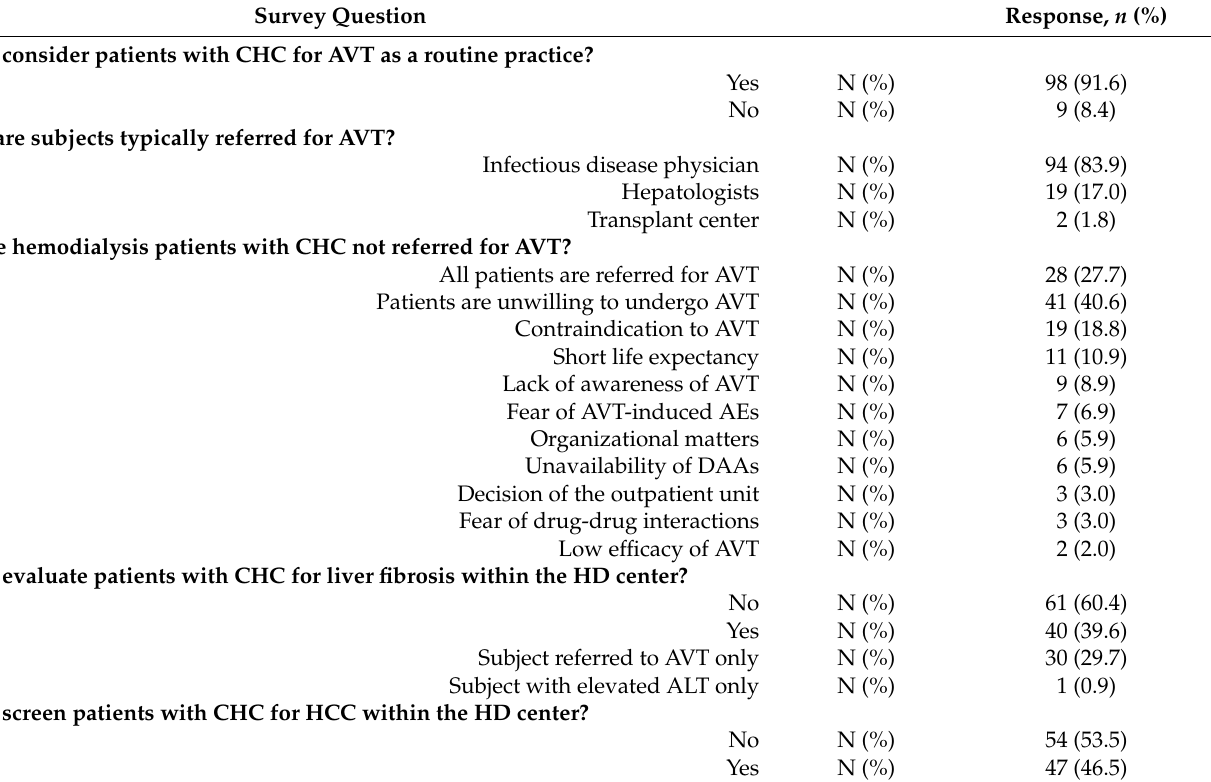
Table 2. Attitudes, strategies, and obstacles in HCV care among dialysis centers in